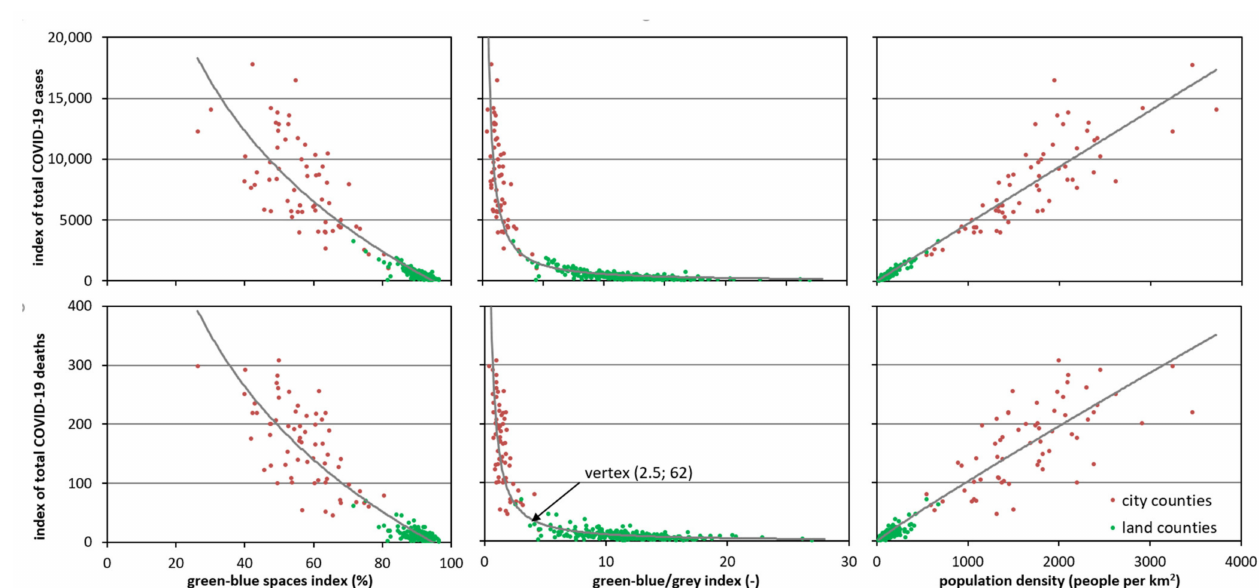
Figure 7. Relationships between the green-blue spaces index (%), green-blue/grey index (–) and population density (people per 1 km 2 ) and index of the total number of COVID-19 cases (people per 100 km 2 ) and index of the total number of COVID-19 deaths (people per 100 km 2 ) in the counties of